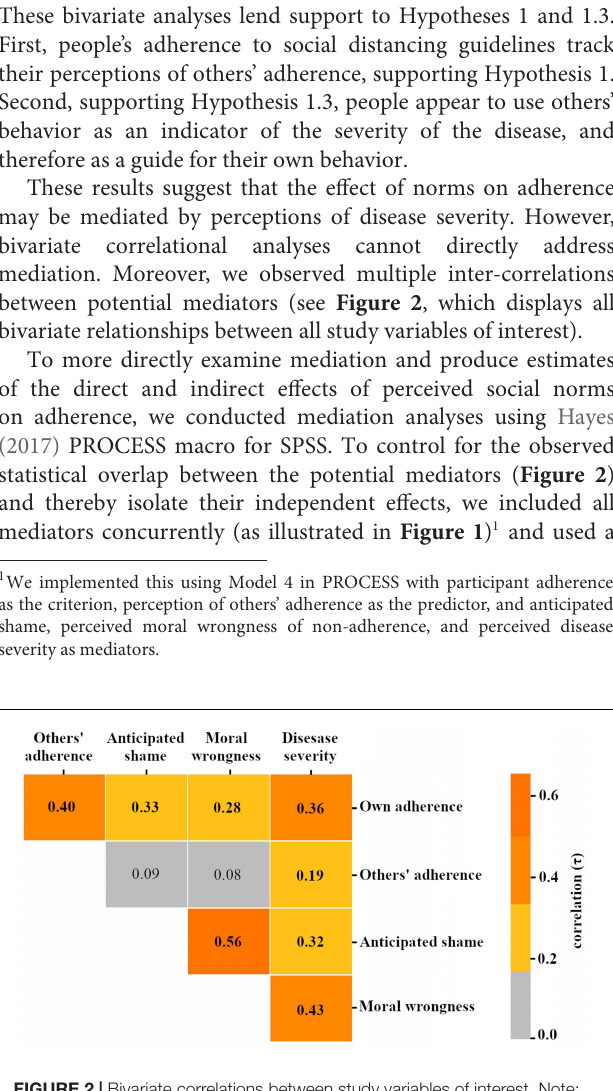
FIGURE 2 | Bivariate correlations between study variables of interest. Note: gray cells indicate non-significant ( p > 0.05) correlations. All colored cells indicate significant ( p < 0.05)